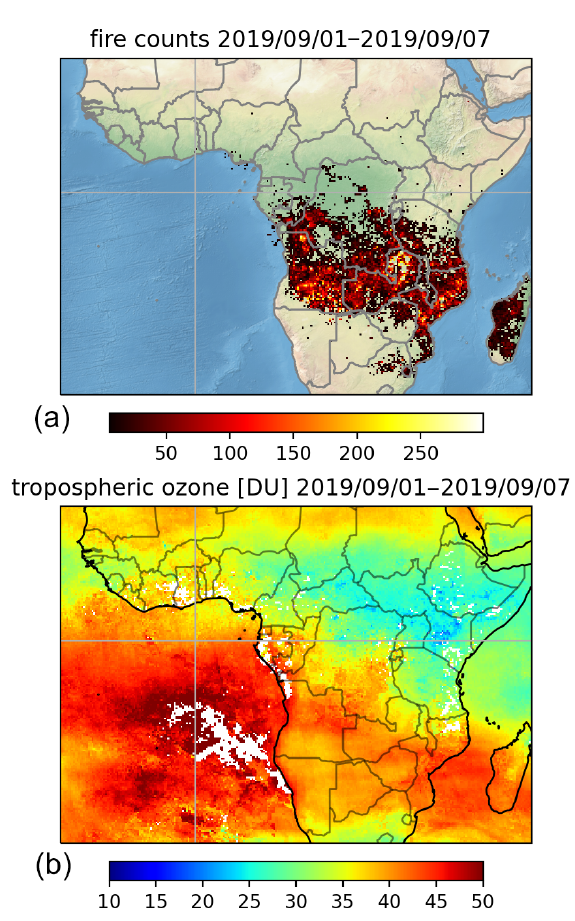
Figure 12. Visible Infrared Imaging Radiometer Suite (VIIRS) ac- tive fire counts for 1–7 September 2019 over Central Africa ( a , image made using Natural Earth) and mean S5P-BASCOE tro- pospheric ozone columns for the same period (b) . Fire data can be downloaded at https://firms.modaps.eosdis.nasa.gov/download/ (last access: May 2022).